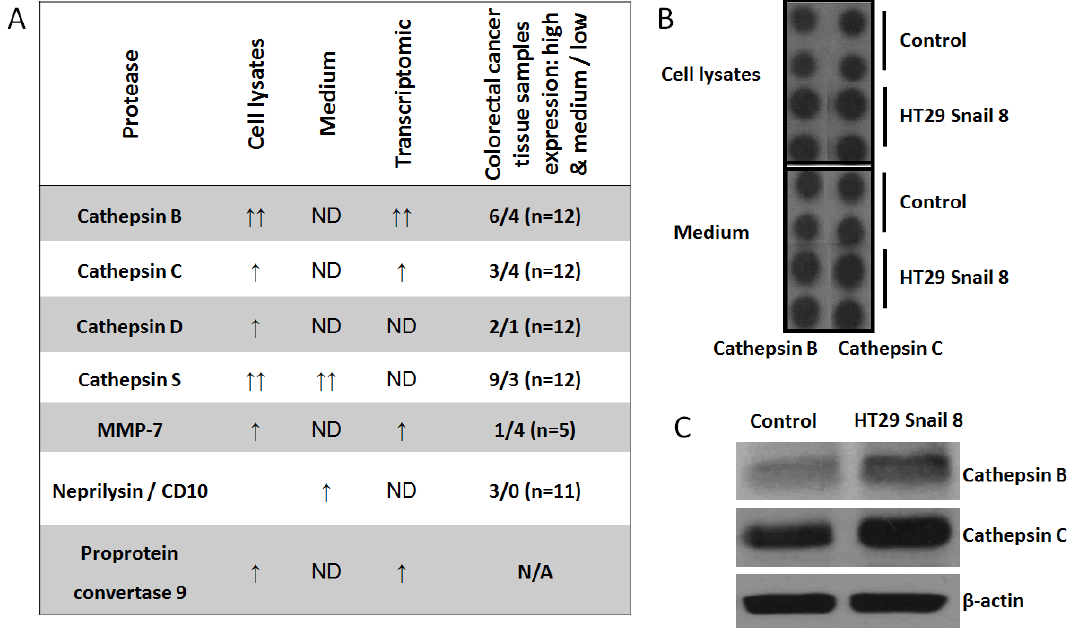
Figure 4. The expression of non-MMPs proteases in HT-29 cells with Snail overexpression. Cell lysates and culture medium were analyzed by using Proteome Profiler Human Protease Array (R&D System, ARY021). ( A ) Comparative analysis of transcriptomic [9] and proteome profiler data from HT-29 cells overexpressing Snail with proteomic analysis of colorectal cancer tissue samples obtained from “The Human Protein Atlas” (https://www.proteinatlas.org). ( B ) Representative picture of cathepsin B and cathepsin C expression in proteome profiler dot technique analysis. Full proteome profiling was shown in Figure S2 ( C ) Western blot analysis of cathepsin B and cathepsin C. ND — not detected; N/A — not